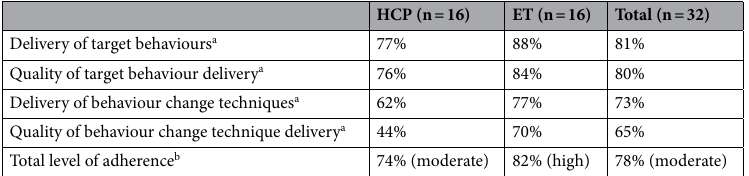
Table 2. Fidelity of HCP and ET audio recorded consultations with men on ADT. a Delivery, and quality of delivery of target behaviours and behaviour change techniques were scored a maximum of 2 points each (0 = poor delivery; 1 = limited delivery; 2 = good delivery). Scores were combined and converted to a percentage (high fidelity = 80–100%; moderate fidelity = 51–79%; low fidelity = 0–50%). b Scores for delivery of target behaviours, quality of target behaviour delivery, delivery of behaviour change techniques and quality of behaviour change technique delivery were combined and converted to a percentage to provide an overall fidelity score (high fidelity = 80–100%; moderate fidelity = 51–79%; low fidelity =